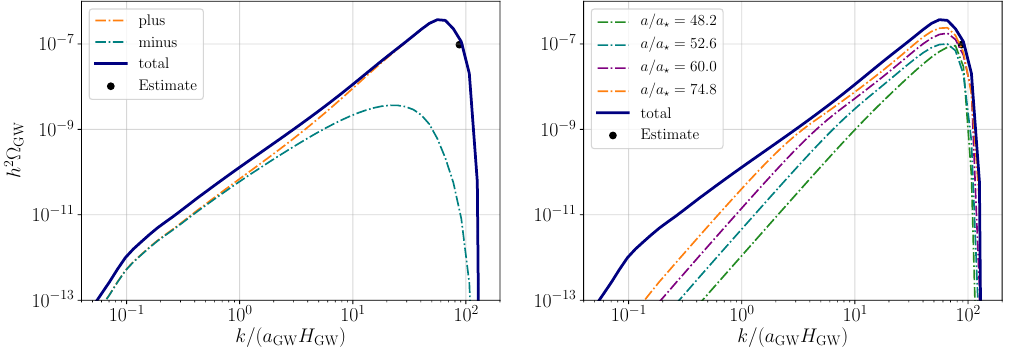
Figure 4: GW spectrum as a function of the physical momentum k / a to the Hubble rate at emission. The spectrum is calculated numerically from the simulated dark photon spectrum shown in Fig. 3. The parameters correspond to benchmark 2 in Table 1. The black dots indicates the estimate in Eq. (45). Left: GW spectrum at the time of emission. The solid blue curve depicts the total spectrum, whereas the dot-dashed orange and cyan curves correspond to positive and negative GW helicities, respectively. Right: Total GW spectrum at different